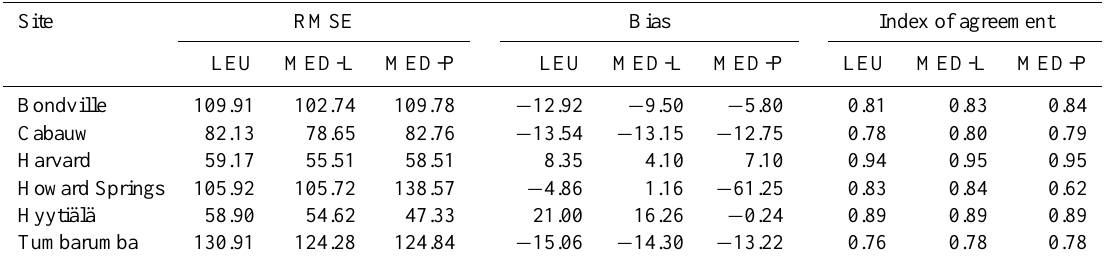
Table 5. Summary statistics of modelled and observed LE at the six FLUXNET sites during daylight hours (9a.m.–18p.m.) and over the peak growing season (for Northern Hemisphere sites, from June-July-August and for Southern Hemisphere sites, from December-January- February). Site RMSE